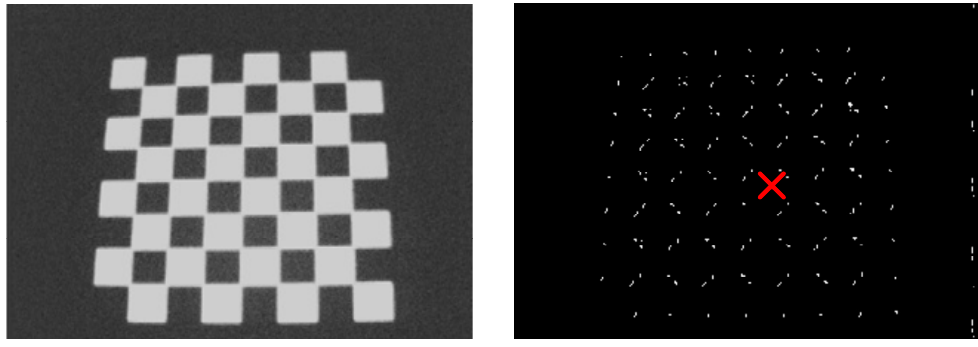
Figure 9. Left : real image acquired by the pixel sensor; right : center of mass (red cross) calculated by the ARM processor over an HCD output from the manycore.